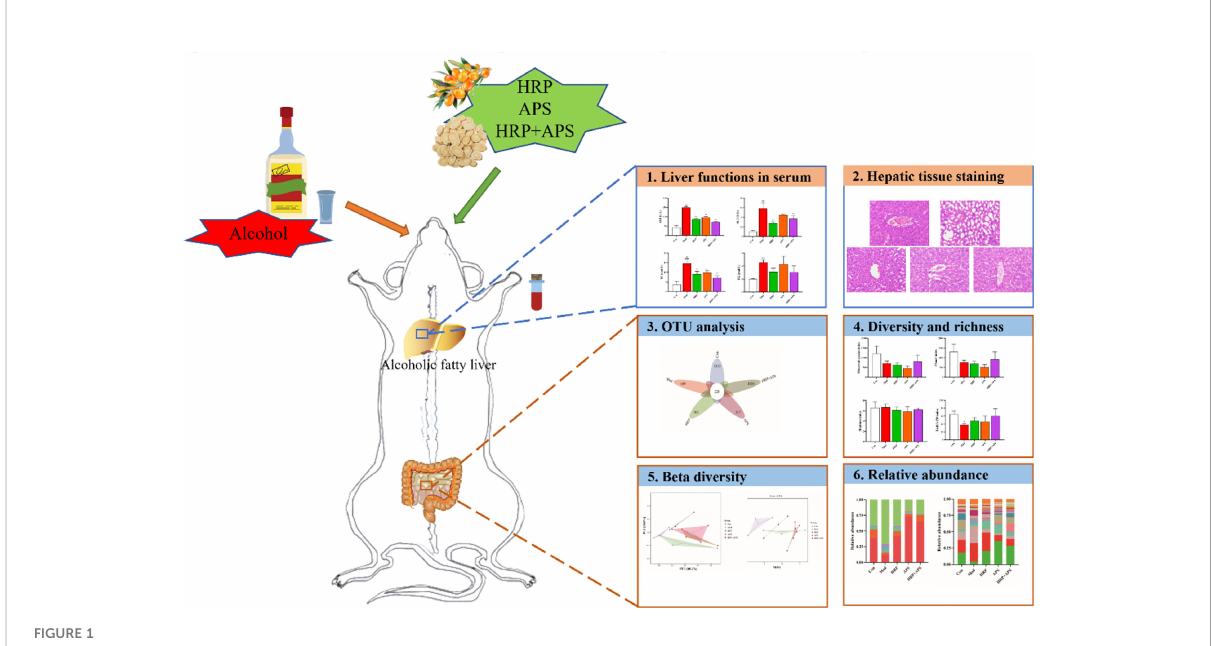
FIGURE 1 Flowchart of the experimental